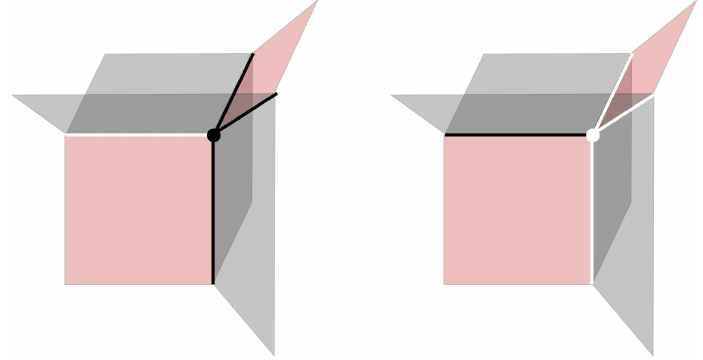
Figure 7 . Two possible types of vertices with either three negative and one positive edges, or three positive and one negative